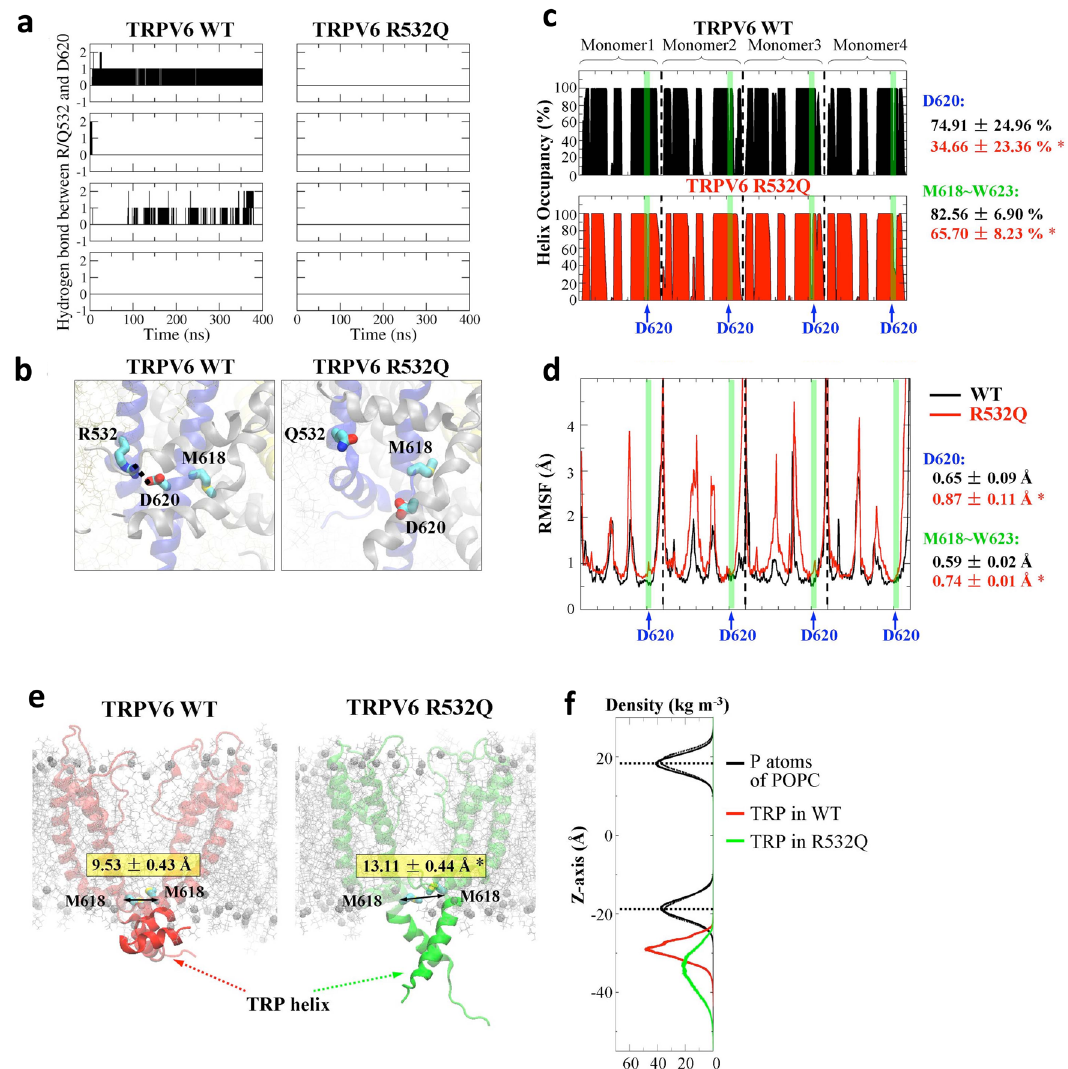
Fig. 3 R532:D620 interaction examined by MD simulation. a Hydrogen bonding between a residue at 532 (R532 or Q532) and D620 as a function of time. b Effect of the R532Q mutation on the D620 conformation. Structural ( c ) and dynamic ( d ) changes in D620 and its proximal region (M618 – W623). The red and black lines show the RMSD values of TRPV6 with and without the R532Q mutation, respectively, during the 400 ns simulations. A higher occupancy value means a more stable secondary structure, while a higher RMSF value indicates higher dynamic fl exibility of the residue. e Effect of the R532Q mutation on the distance between the two diagonal M618 in a TRPV6 tetramer. f Effect of the R532Q mutation on the mass density of phosphate (P) atoms in POPC lipid (black curves) and the TRP helix of TRPV6 along the Z -axis. The membrane surface positions are indicated by the density peaks of lipid P atoms (dotted lines). Note: for a display purpose, shown density values of POPC P atoms were reduced by ×10 from the real